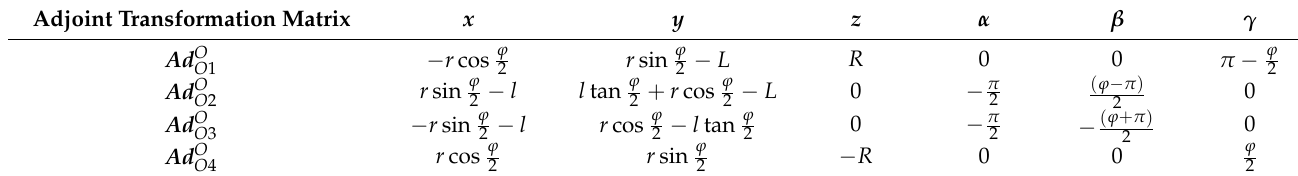
Table 1. Parameters of translation transformation and rotation transformation. Adjoint Transformation Matrix